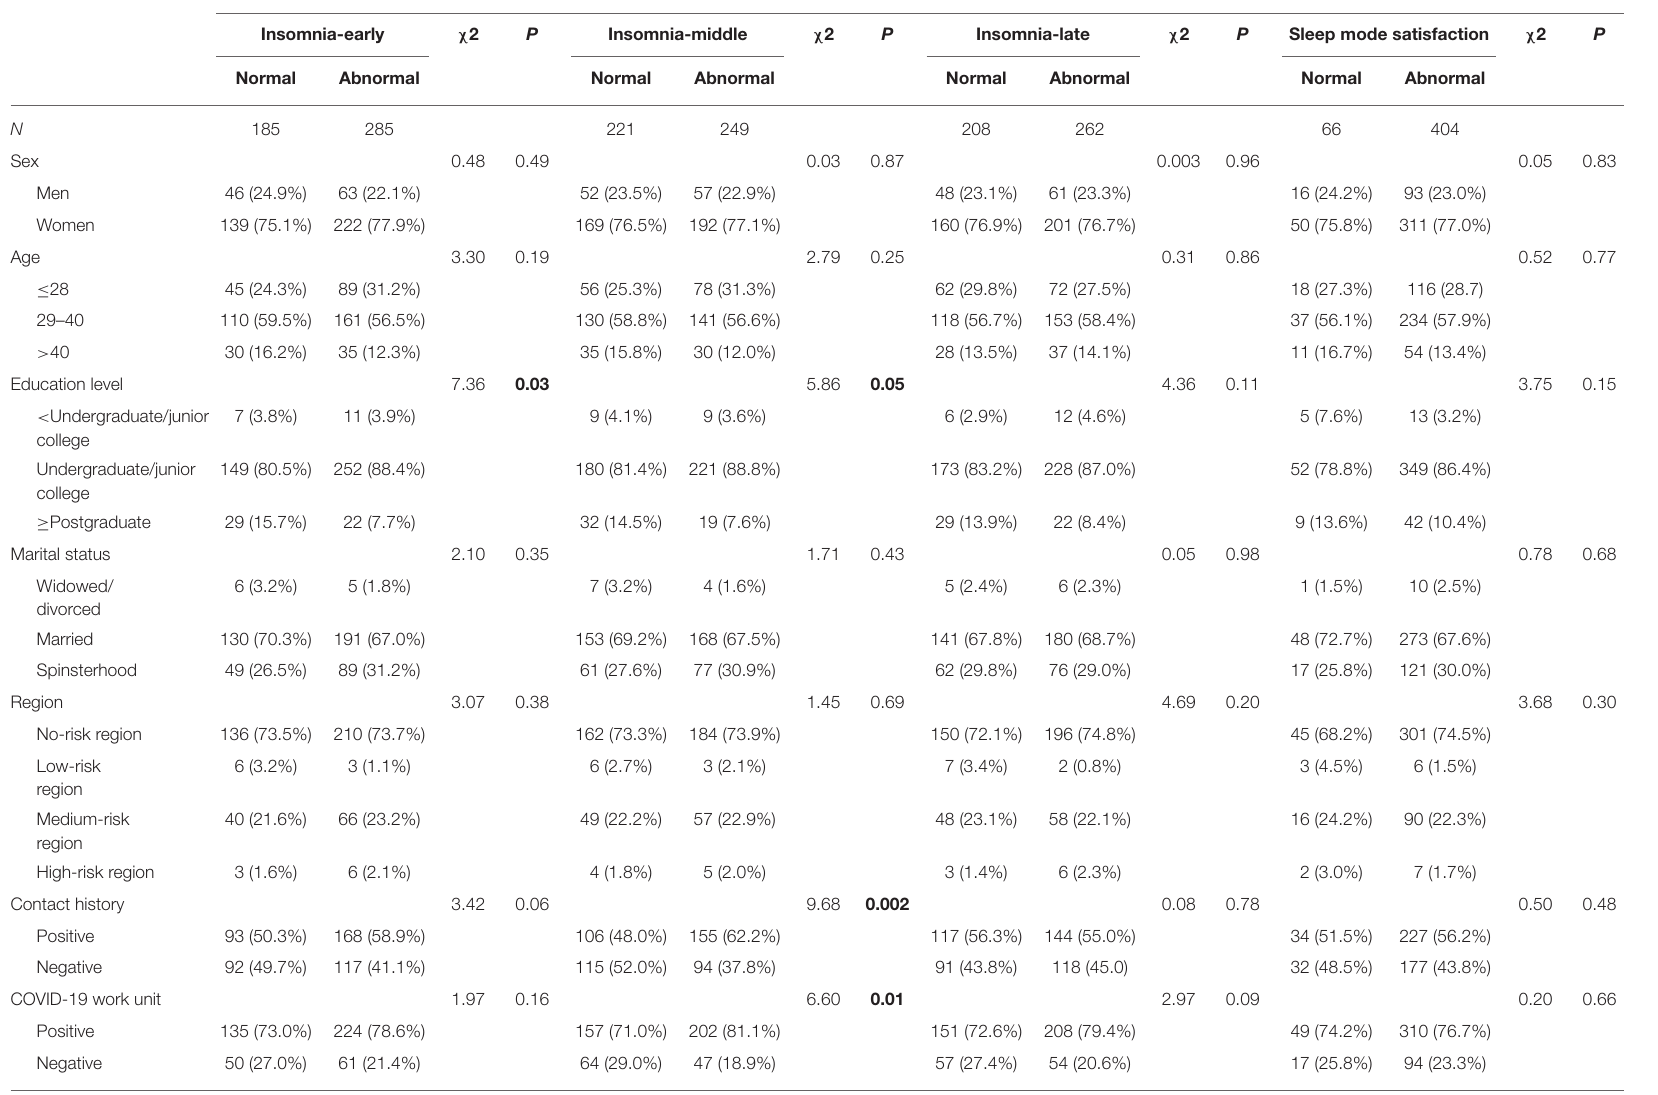
TABLE 4 | Factors associated with the symptoms of insomnia in two